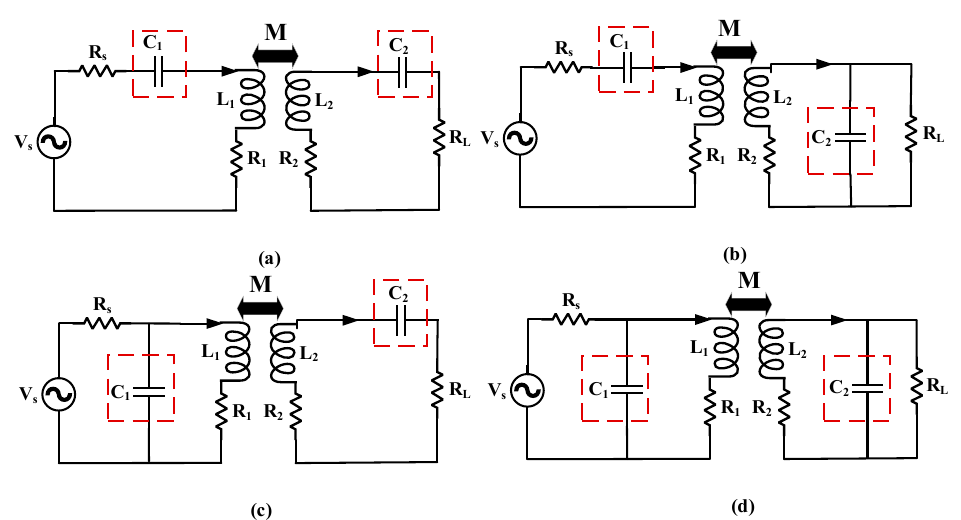
Figure 14. Basic compensation topologies: ( a ) series–series (SS), ( b ) series–parallel (SP), ( c ) parallel–series (PS), and ( d ) parallel–parallel (PP).